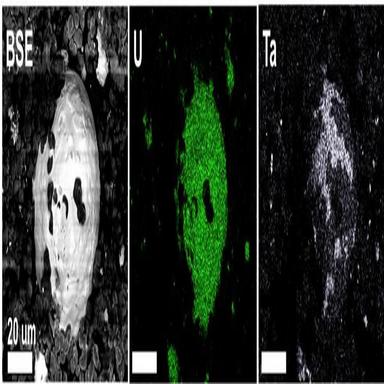
Image and elemental X-ray maps of a second U spheroid. A Ta map shows that it is concentrated at various spots on the U surface.